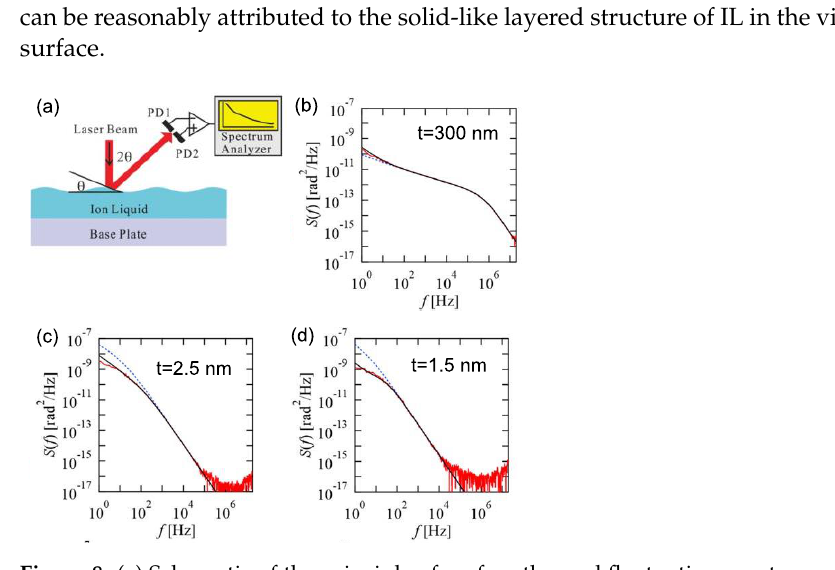
Figure 8. ( a ) Schematic of the principle of surface thermal fluctuation spectroscopy. ( b – d ) Surface thermal fluctuation spectra for 300-nm-, 2.5 nm- and 1.5 nm-thick IL [emim][TFSA] films. The solid red line is the experimental result and the dashed blue line and the solid black line are the fitting results based on the simple Newtonian liquid model and a modified model with the inclusion of viscoelasticity, respectively. Reproduced with permission from ref. [36]. Copyright 2021, IOP Publishing Ltd.